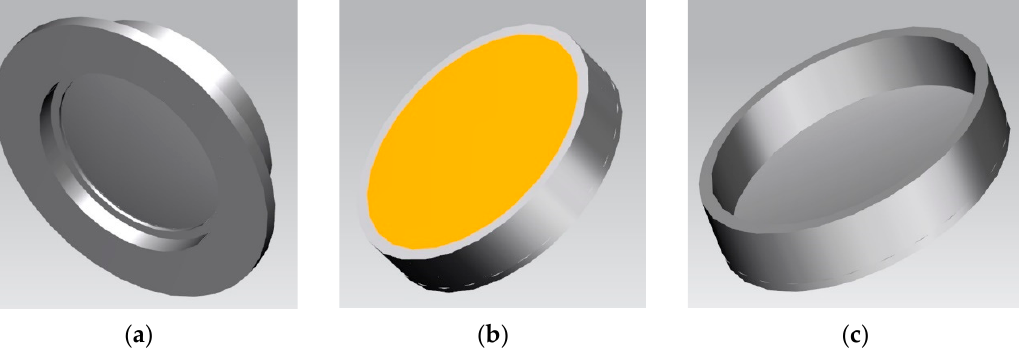
Figure 6. The secondary mirror of the Cassegrain system. ( a ) The components of the secondary mirror; ( b ) The structure of the circle mirror; ( c ) The non-design domain of the circle mirror.